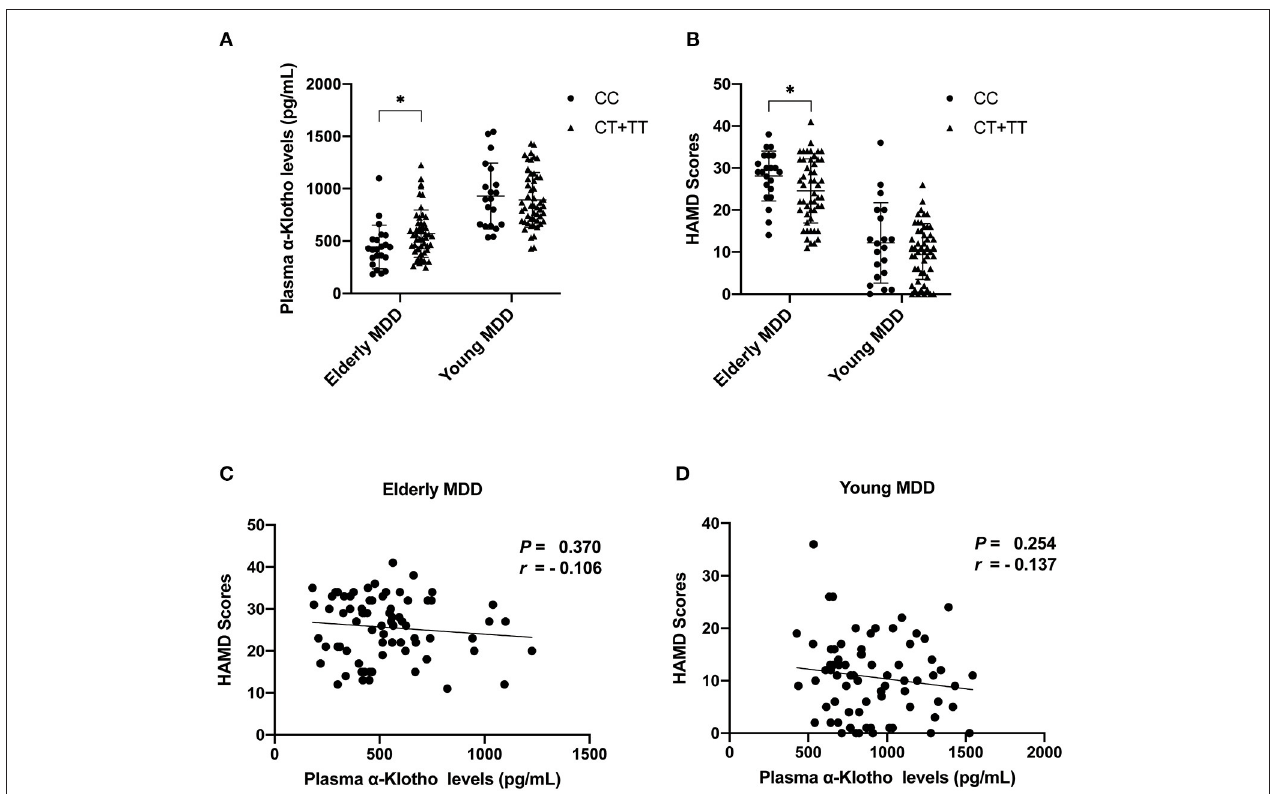
FIGURE 3 | Plasma α -Klotho levels (A) and HAMD scores (B) in MDD patients carrying Klotho polymorphism rs9315202, and HAMD scores vs. α -Klotho levels in elderly (C) and young (D) patients. MDD, major depressive disorders; * P <